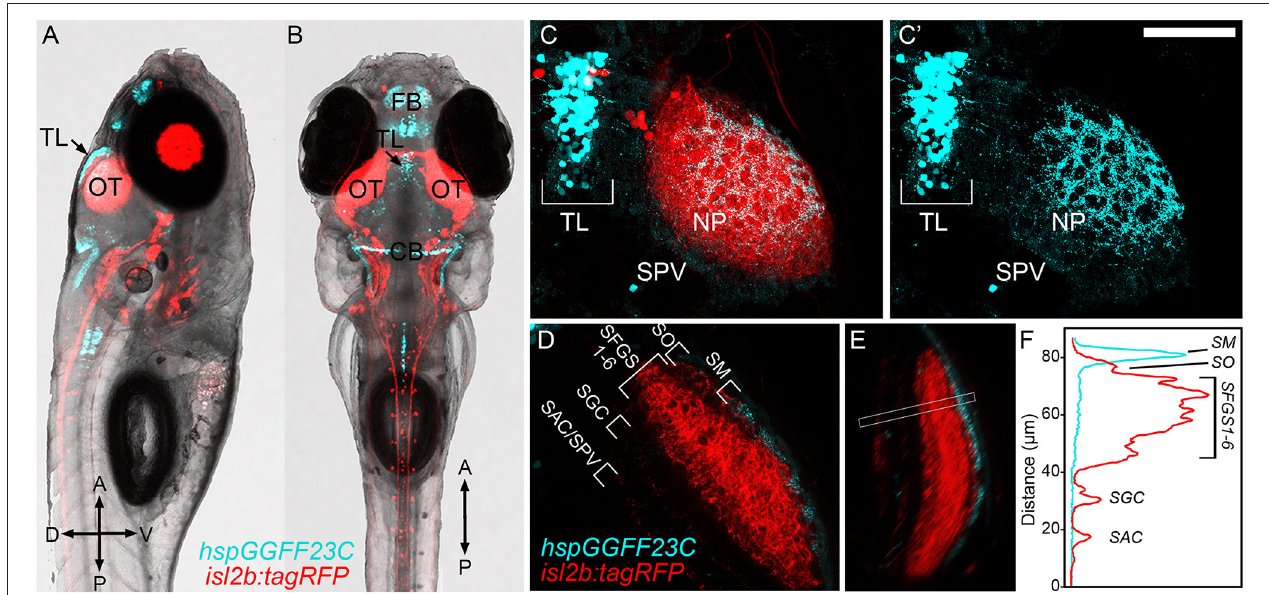
FIGURE 2 | hspGGFF23C transgenic labels TL neurons that project to SM. (A,B) Low-resolution confocal images of 7 dpf triple transgenic Tg(hspGGFF23C,uas:egfp,isl2b:tagRFP) larva from side- and dorsal-view. (C) Higher magnification maximum projection images of TL and one tectal lobe of larva in (A,B) . Merged fluorescence channel shown in (C) , hspGGFF23C -driven EGFP channel shown in (C ′ ) . Note presence of EGFP-positive cells in TL and neurite plexus formed in tectal neuropil and lack of labeling in SPV layer of tectum. (D) Single confocal image through tectal neuropil. Note discrete EGFP labeling in the superficial SM layer of tectal neuropil. (E) Rotated side-view of image volume in (D) , orientation orthogonal to the neuropil layers. (F) Fluorescence intensity profile measurement along line indicated by box in (E) . Note peak in EGFP signal in the superficial SM layer. Scale bar: 300 µ m in (A,B) , 80 µ m in (C) , and 60 µ m in (D,E)